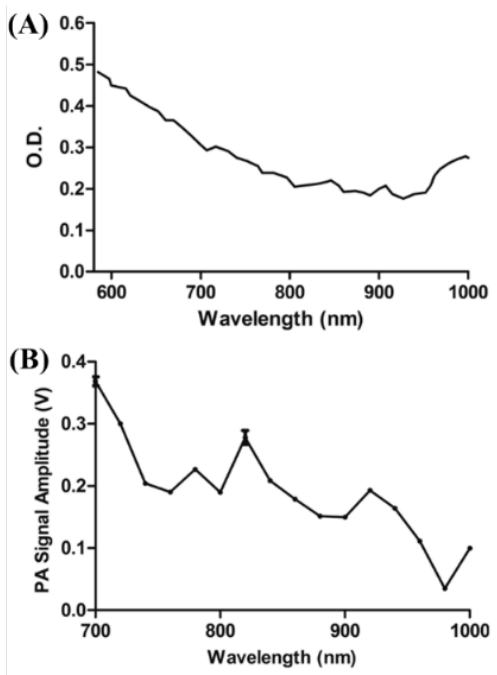
Figure 13. Optical characteristics of DNDs suspended in DI water as functions of the wavelength. ( A ) Absorption spectrum measured with an integrating sphere, and ( B ) PA spectrum. Reprinted from Zhang et al., J. Biomed. Opt., 2013, 18, 2: 026018 [28], with permission from the Optical Society of America.